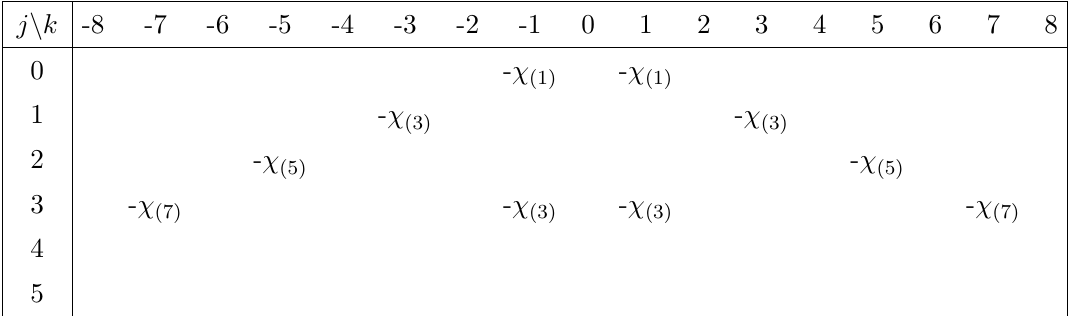
( m ) in the series expansion of (cid:24) 1 ; Sp(1) Sp(1) j;k = (cid:31) Sp(1) ( m ( n ) Sp(1) ( n )